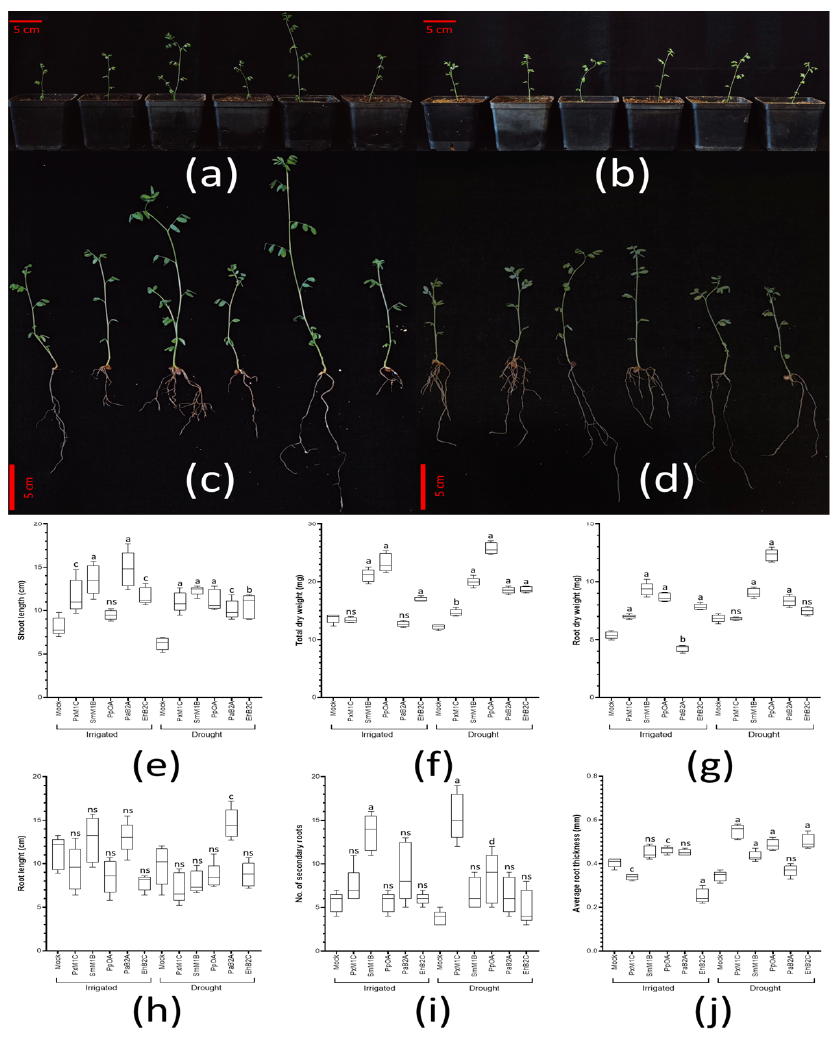
Figure 8. Plant-growth promotion and drought-tolerance enhancement via inoculant treatment. The pictures show the side view and the full plant view of treated seedlings under ( a , c ) continuous irrigation, and ( b , d ) water restriction (drought). The box plot graphs show the ( e ) shoot height; ( f ) root length; ( g ) number of secondary roots; and ( h ) average root thickness. Finally, the ( i ) root dry weight, and ( j ) total dry weight were recorded for each treatment and condition applied. Four independent experiments (each one with n = 5 biologically independent samples) were prepared in this test. Whiskers represent the minimum to maximum data range, and the median is represented by the central horizontal line. The upper and lower limits of the box outline represent the first and third quartiles. Here, ‘Mock’ stands for the control set of seedlings. ‘ Px M1C’ represents seedlings treated with Paenibacillus xylanexedens MS M1-C; ‘ Sm M1B’, with Stenotrophomonas maltophilia MS M1-B; ‘ Pp OA’, with Paenibacillus pabuli BB Oeiras A; ‘ Pa B2A’, with Paenibacillus amylolyticus BB B2-A; and ‘ Eh B2C’, with Enterobacter hormaechei BB B2-C. The sets of data were compared using a two-way ANOVA test and 95% confidence intervals (with Tukey’s post-tests), where letters indicate a statistically significant difference at a p < 0.0001; b p < 0.001; c p < 0.01; and d p < 0.01; ns stands for statistically non-significant, compared to the mock set in each condition (irrigation and drought).